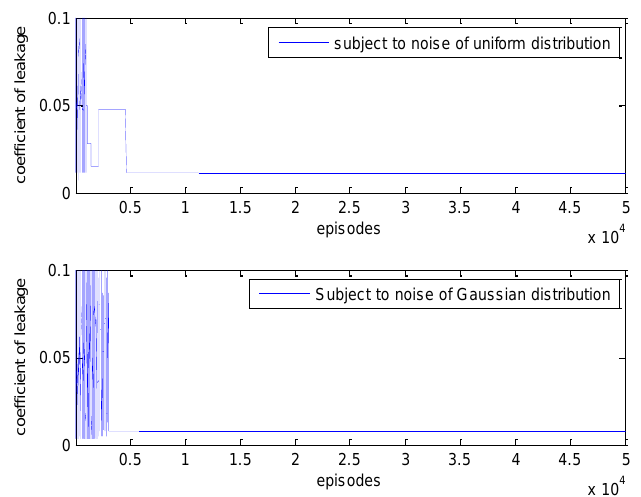
Figure 11. The learning process of leakage coefficient ( 𝜆 𝑐 was predetermined as 0.01).